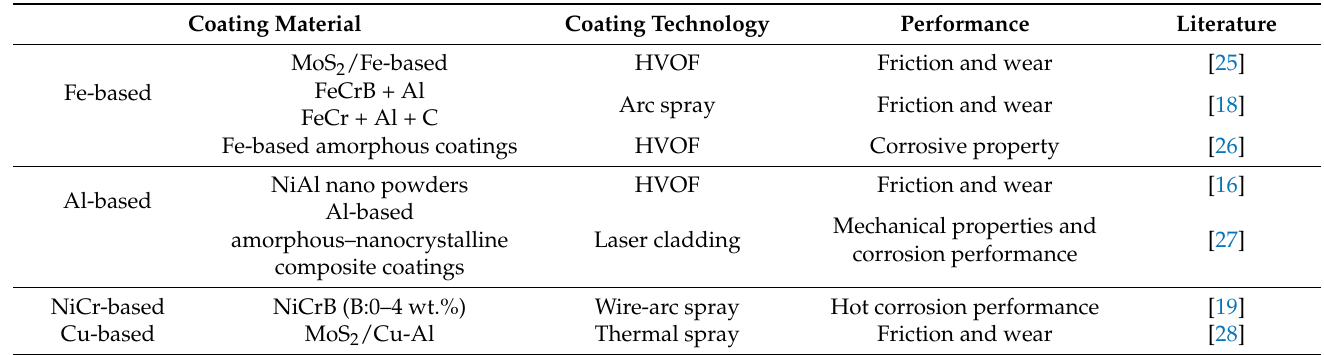
Table 2. Comparison of different technologies for preparing alloy coatings on the